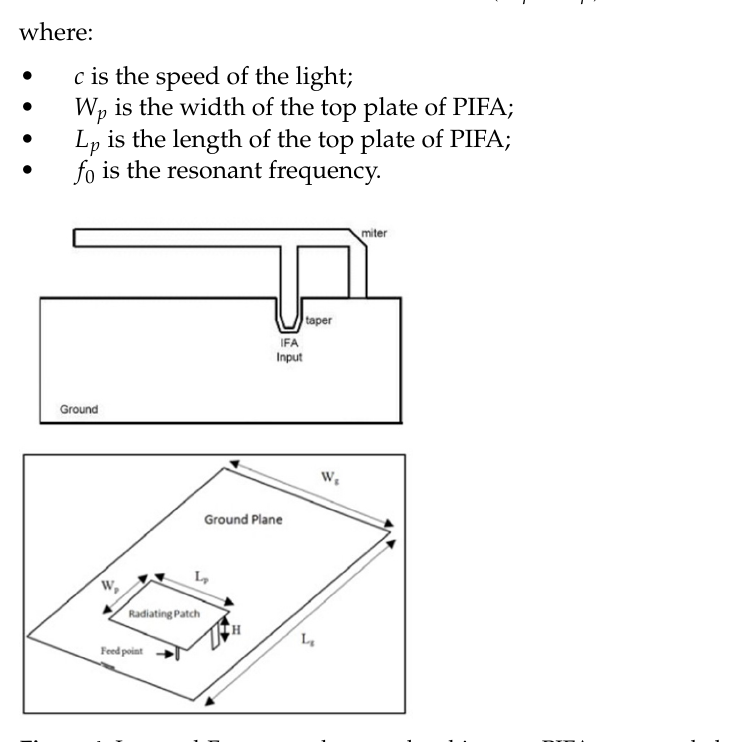
Figure 4. Inverted-F antenna above and architecture PIFA structure below